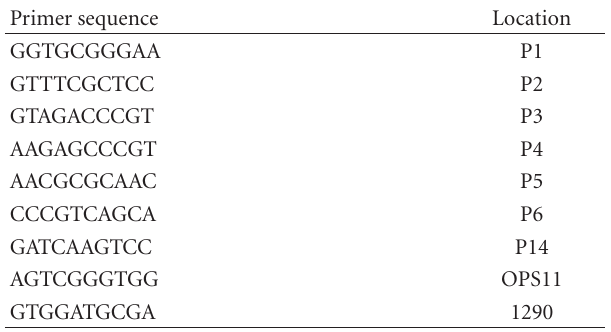
Table 3: Phenotypic features of Lactococcus garvieae and Streptococ- cus iniae recovered from diseased rainbow trout in 6 states of